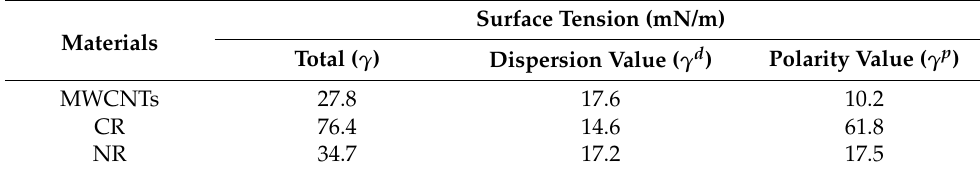
Table 2. The surface tension of MWCNTs, CR, and